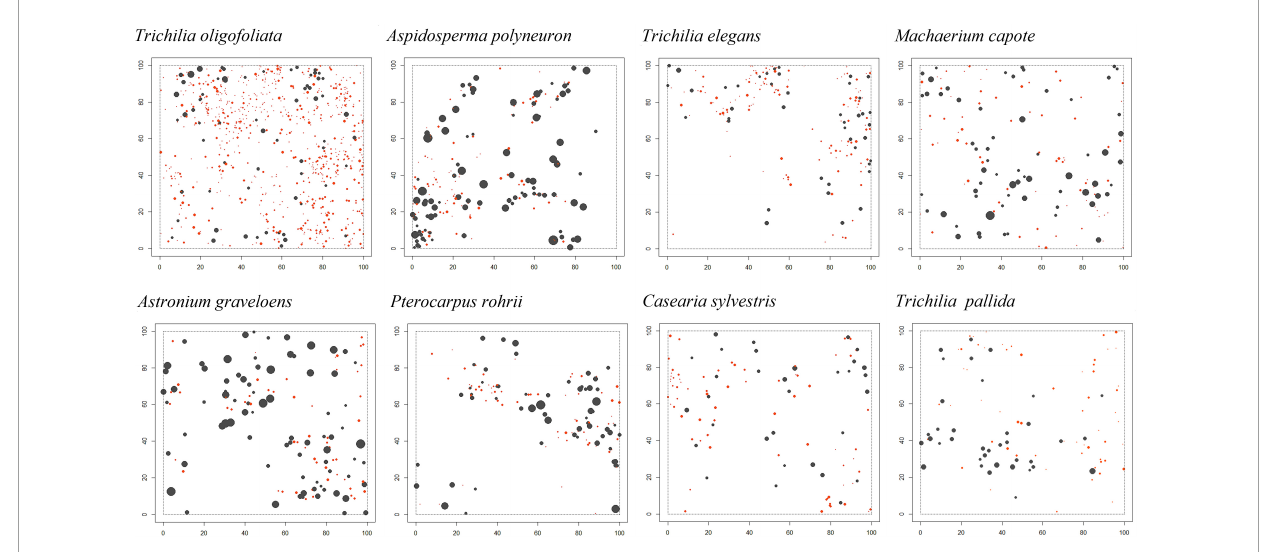
FIGURE1 Spatial distribution map of individual trees of the 8 study species in the 1-ha forest plot. Black disks, large trees ( ≥ 10 cm dbh; matures); Red disks; small trees ( ≤ 10 cm dbh; saplings). The size of the disks is proportional to the dbh of the trees. See Table 1 for population and structural